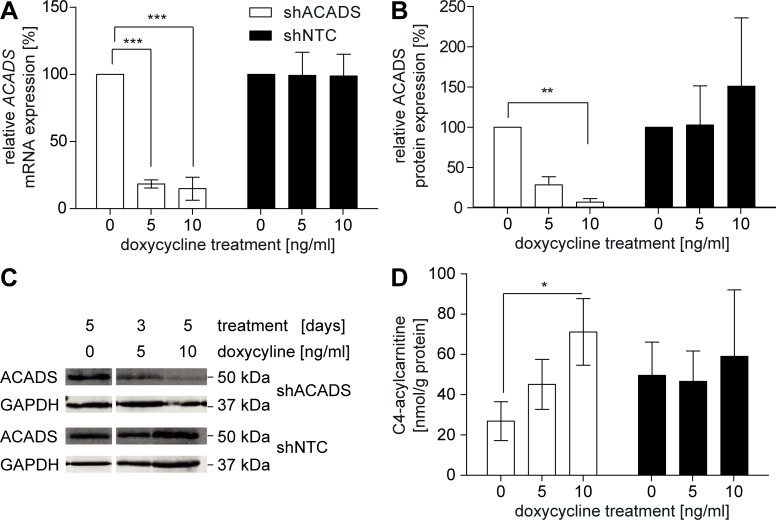
Phenotypes of the shACADS and shNTC knockdown Huh7 cells.Doxycycline-induced knockdown of ACADS resulted in a long-term decrease of protein abundance and mRNA expression, and an intracellular accumulation of C4-acylcarnitine, which reflects the ACADS substrate C4-CoA. (A) RT-qPCR analysed mRNA of four independent experiments, shown as mean ± SD. (B, C) Western blot analysis of ACADS protein in shACADS and shNTC knockdown Huh7 cell lysates. Western blotting analysed 10 μg of cell lysate per sample depicted exemplary for one (C) of four experiments (B). ** = p < 0.01 (one sample t-test). mRNA (A) and Protein (B) were harvested after 3 or 5 days of treatment with 0, 5, and 10 ng/mL doxycycline, respectively. *** = p < 0.001 (one-sample t-test). (D) Intracellular C4-acylcarnitine measurement in stably transduced Huh7 cells. Values of four independent experiments are expressed as mean ± SD. * = p< 0.05 (Kruskal-Wallis one-way ANOVA with Dunn’s post hoc test). NTC = non-target control.